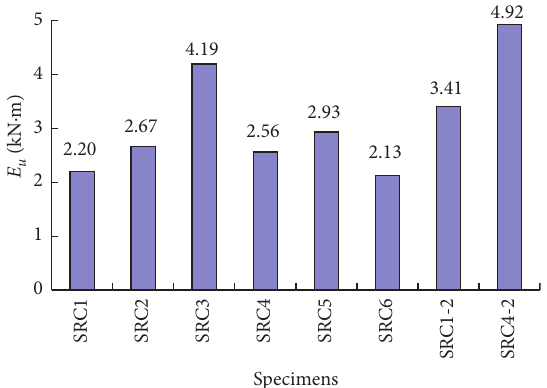
Figure 9: Ultimate hysteresis energy of specimens. Figure 10: Ultimate equivalent viscous damping coefficient of